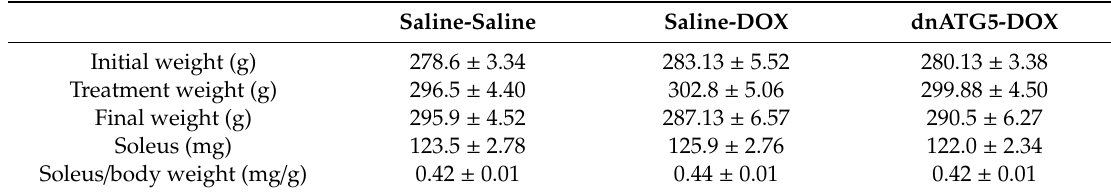
Table 1. Di ff erences in body weight, soleus muscle weight, and the ratio of soleus muscle weight to body weight between experimental groups in experiment